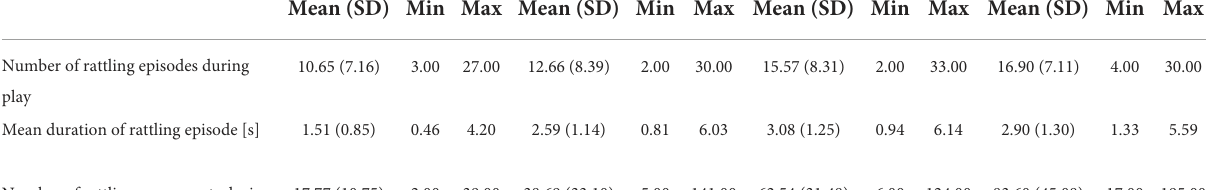
TABLE 2 Descriptive statistics at each time